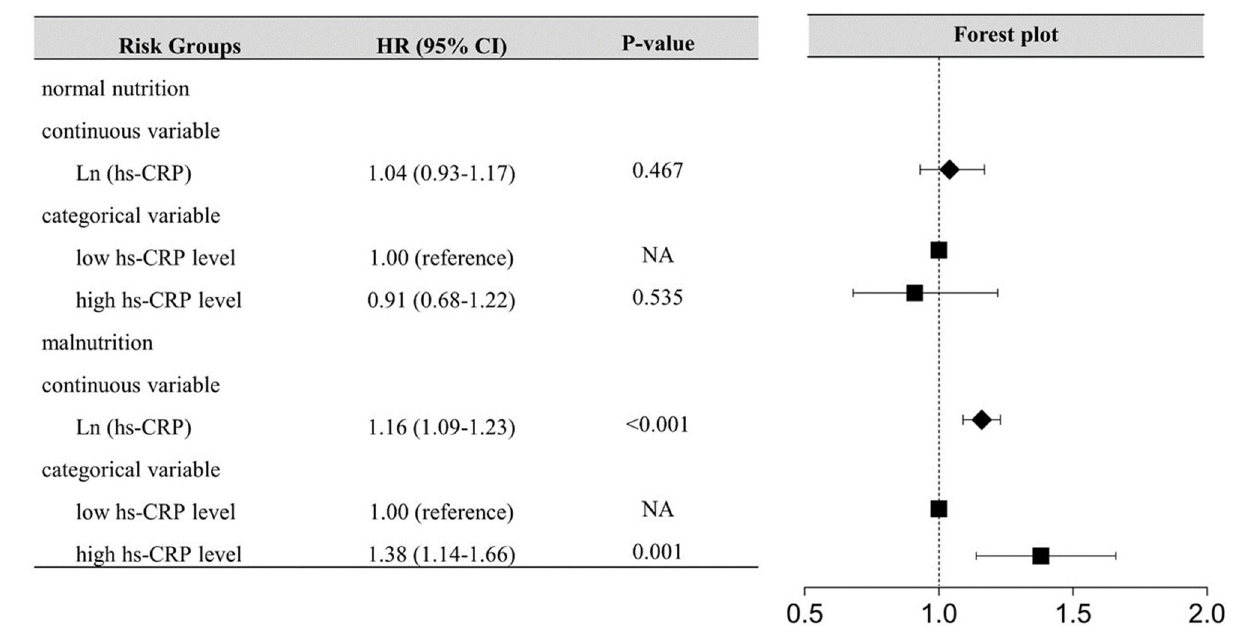
FIGURE 2 | Inflammation-Associated All-cause Mortality Risk According to nutritional status. hs-CRP, High-sensitivity C-reactive protein; The model for inflammation-associated risk according to nutritional status adjusted for age, gender, previous AMI, PCI, anemia, stroke, CHF, CKD, aspirin, AMICAD, angiotensin-converting enzyme inhibitor or angiotensin receptor blocker, beta-blockers, calcium channel blockers, and oral antidiabetics.